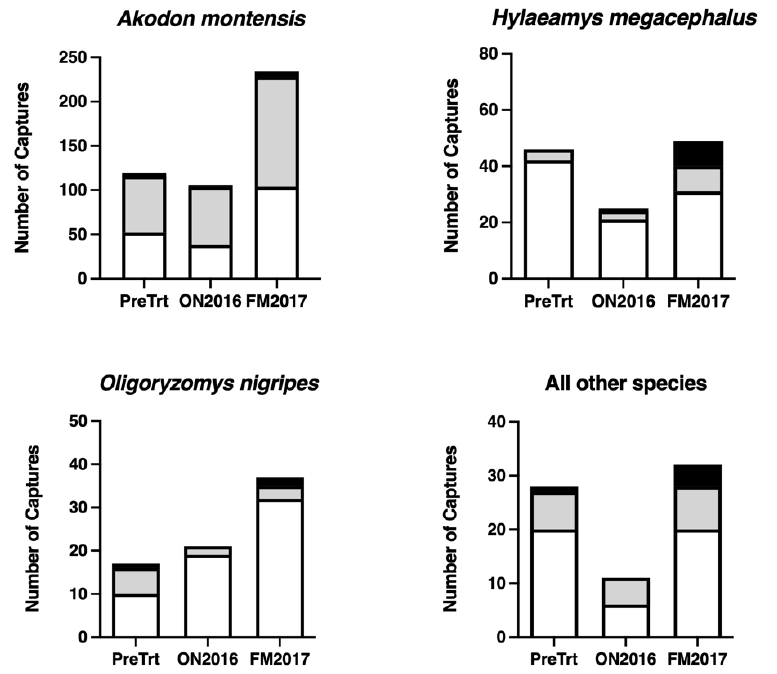
Figure 3. The number of unique individuals per session by age class for Akodon montensis , Hylaeamys megacephalus , Oligoryzomys nigripes , and all other species. Juveniles are shaded in black, subadults are shaded in light gray, and adults are shown in white. Pre-treatment sampling (PreTrt) was